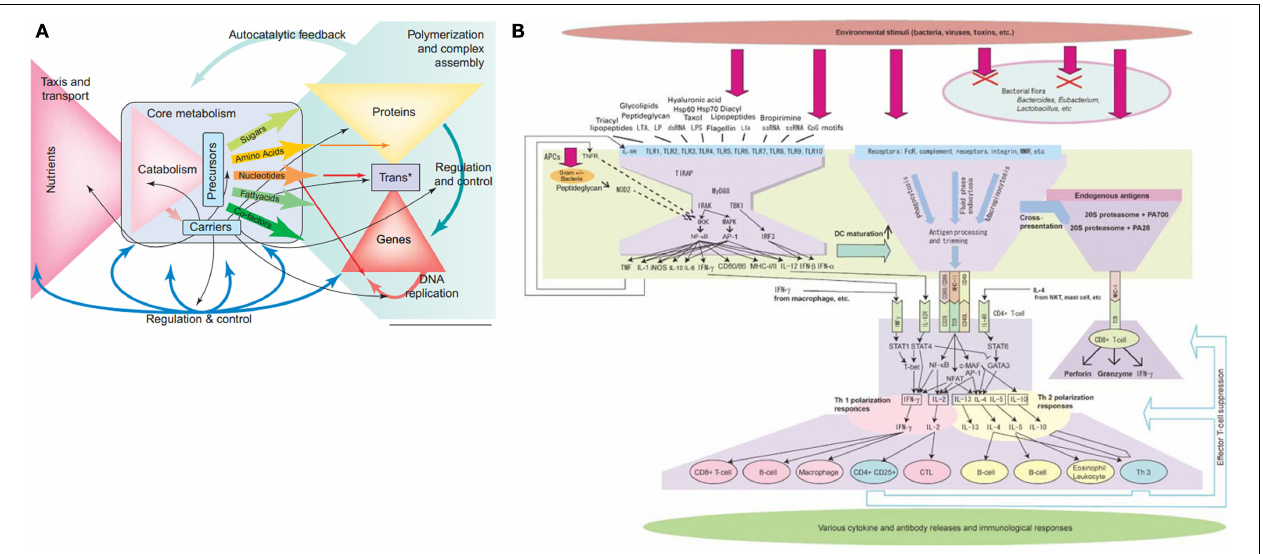
FIGURE 3 | Bow-tie network architecture of metabolism (reprinted from Csete and Doyle, 2004) and the immune system (reprinted from Kitano and Oda,